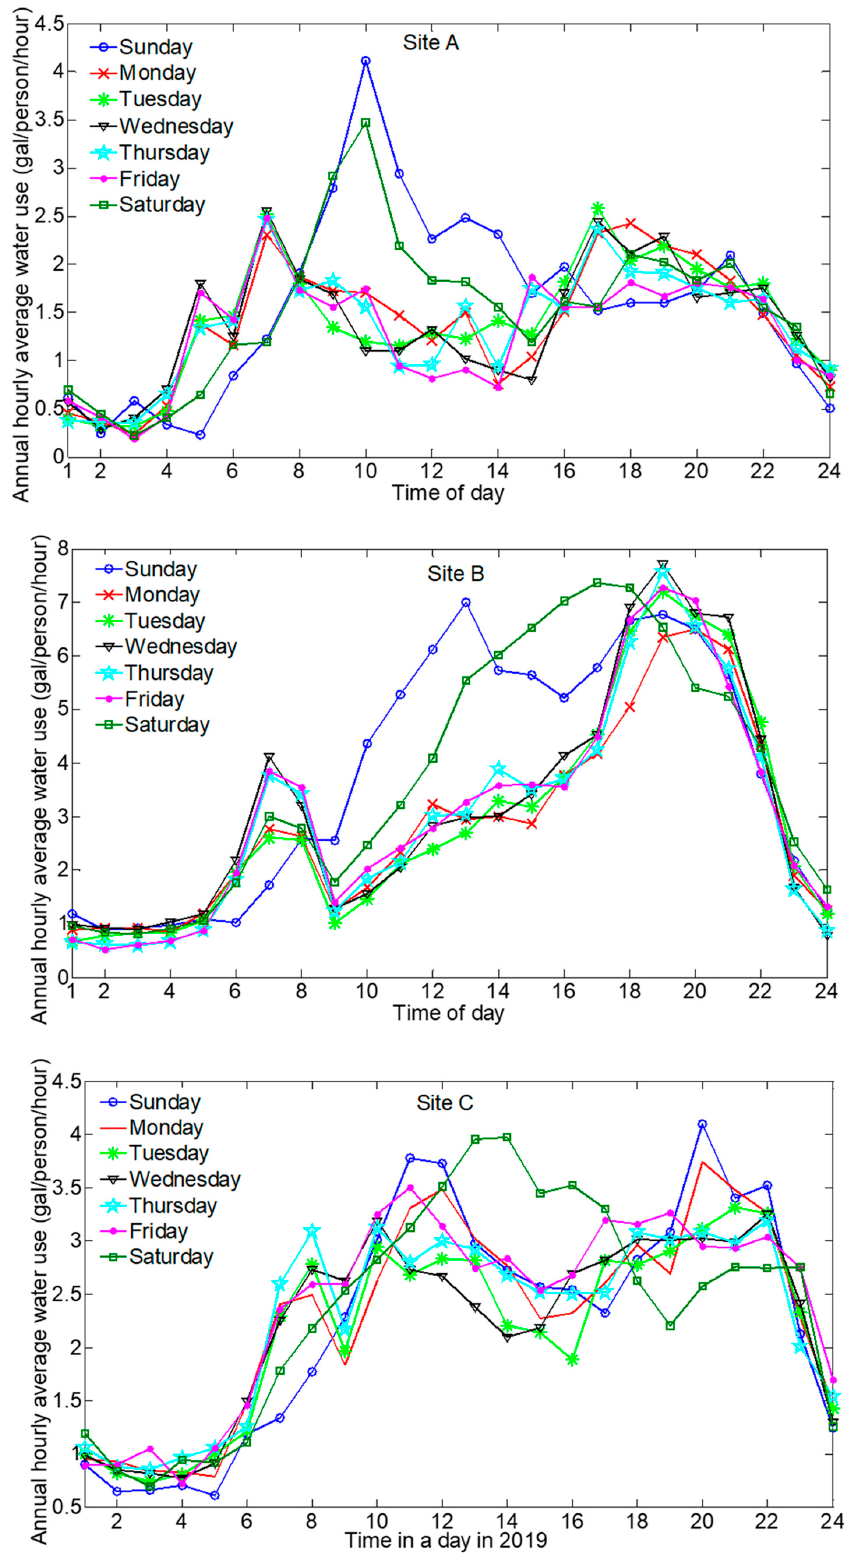
Figure 3. Average hourly water usage for the year 2019. The indicated hourly data for each day of the week represent averages for the given day over the entire year. High water use occurs primarily during the time period of about 7–23. As expected, there is low water use occurs during the nighttime/early morning period of 23–5.